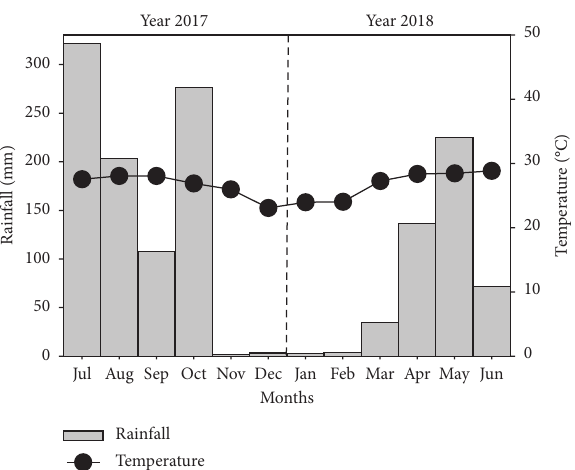
Figure 2: Climate condition and average temperature ( ° C)